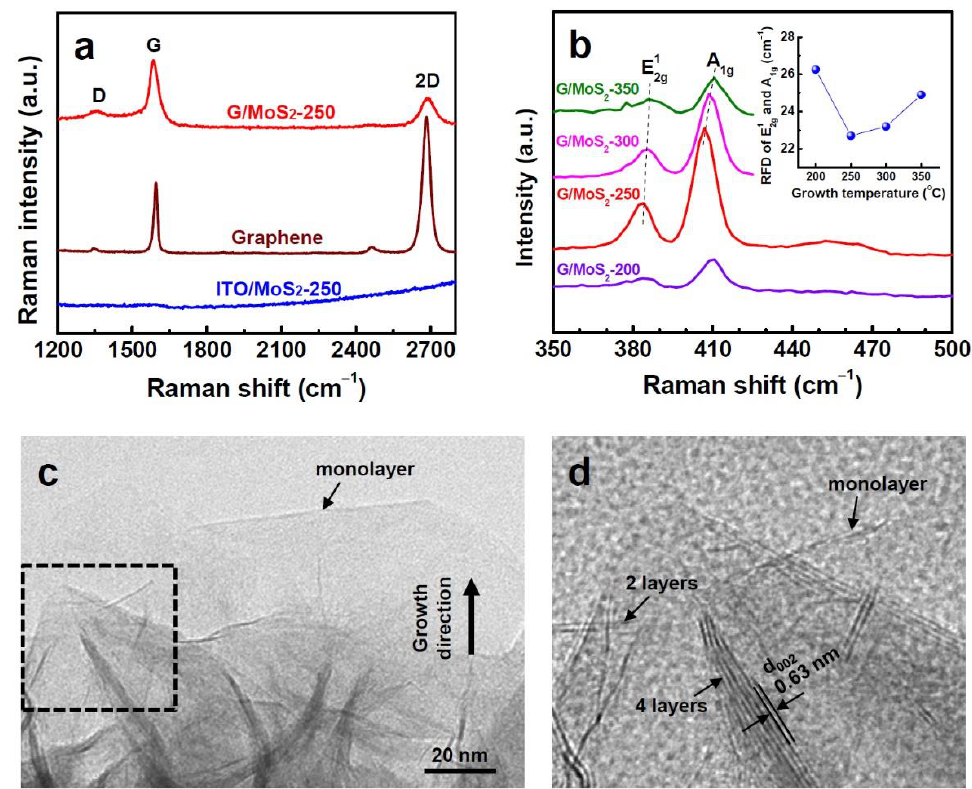
Figure 3. ( a ) Raman spectra of ITO/MoS 2 -250, G/MoS 2 -250, and pristine graphene. ( b ) Raman spectra of G/MoS 2 -200, G/MoS 2 -250, G/MoS 2 -300, and G/MoS 2 -350. The inset shows the RFD between the E 12g and A 1g Raman modes. ( c ) and ( d ) low-magnification and high-resolution TEM images of MoS 2 nanosheets of G/MoS 2 -250, respectively.